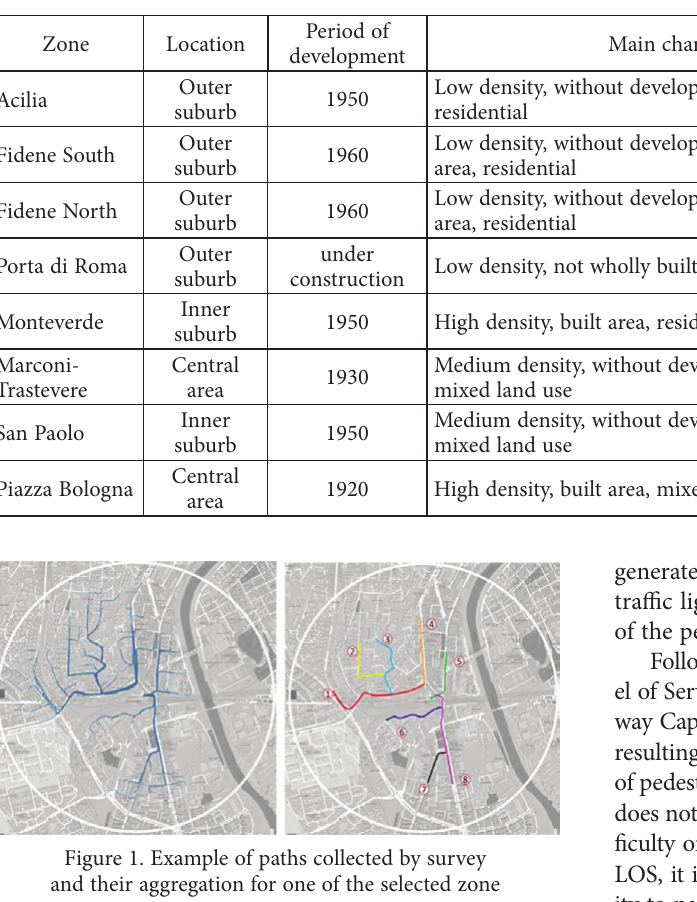
Table 2. Selected zones for the analysis, their main characteristics, and particular attractor points